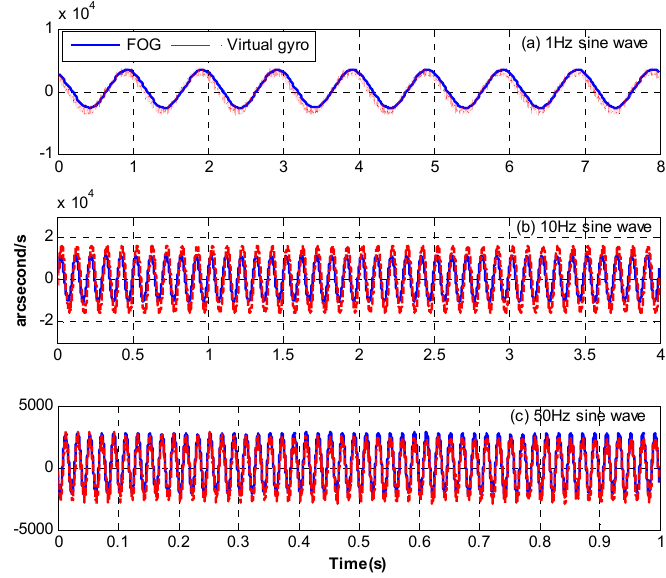
Figure 11. Time-domain wave of the FOG and virtual gyro. ( a ) 1 Hz sine wave, ( b ) 10 Hz sine wave, ( c ) 50 Hz sine wave.